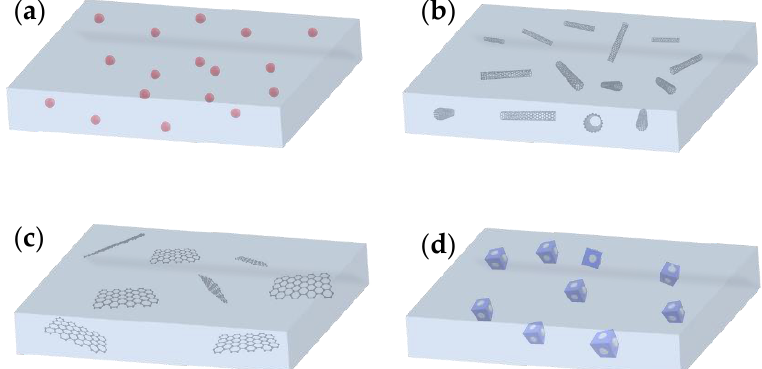
Figure 1. MMMs with different dimensional nanofillers; ( a ) zero-dimensional nanomaterial filled MMM (nanoparticles); ( b ) one-dimensional nanomaterial filled MMM (carbon nanotube for example); ( c ) two-dimensional nanomaterial filled MMM (graphene oxide nanosheet for example); ( d ) three-dimensional nanomaterial filled MMM (microporous nanomaterials).